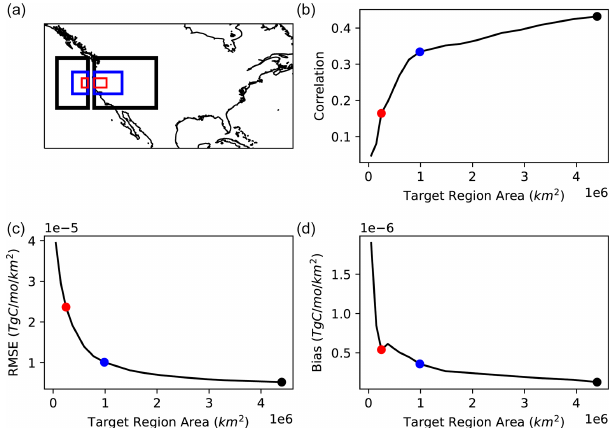
Figure 4. Effect of monthly averaged horizontal ventilation wind conditions on CO 2 flux anomaly estimation using CarbonTracker outputs. CO 2 flux anomaly estimation error with respect to lower troposphere (a) wind angle and (b) wind speed. (c) CO 2 flux anomaly estimation error averaged over each month of the year. Relative error is unitless and is the difference between each pair of CarbonTracker XCO 2 flux anomaly estimates using Eq. (1) and reference CarbonTracker surface CO 2 flux anomaly outputs, and it is divided by the standard deviation of the reference CarbonTracker surface CO 2 flux anomaly